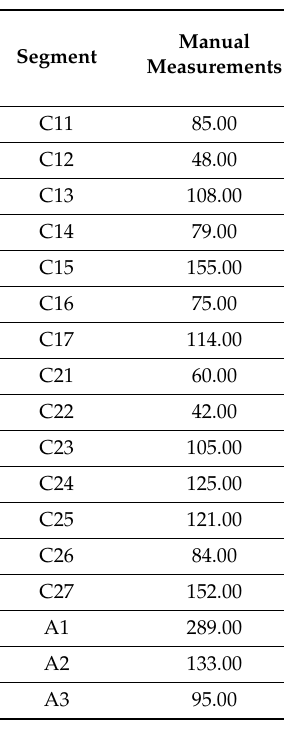
Table 8. Manual measurements vs. sUAV measurements of the accident scene in extreme operating conditions of Kuwait.